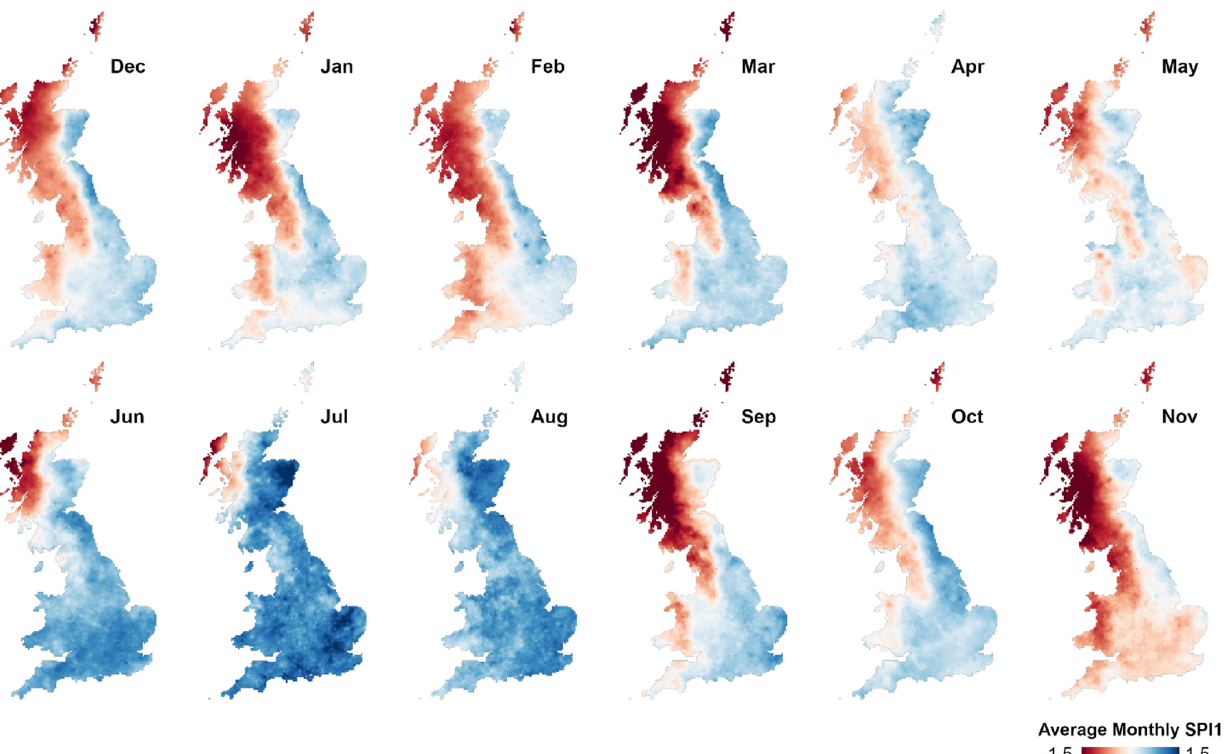
Figure 2. Average monthly SPI-1 values under NAO+ conditions (January 1900–December 2015).